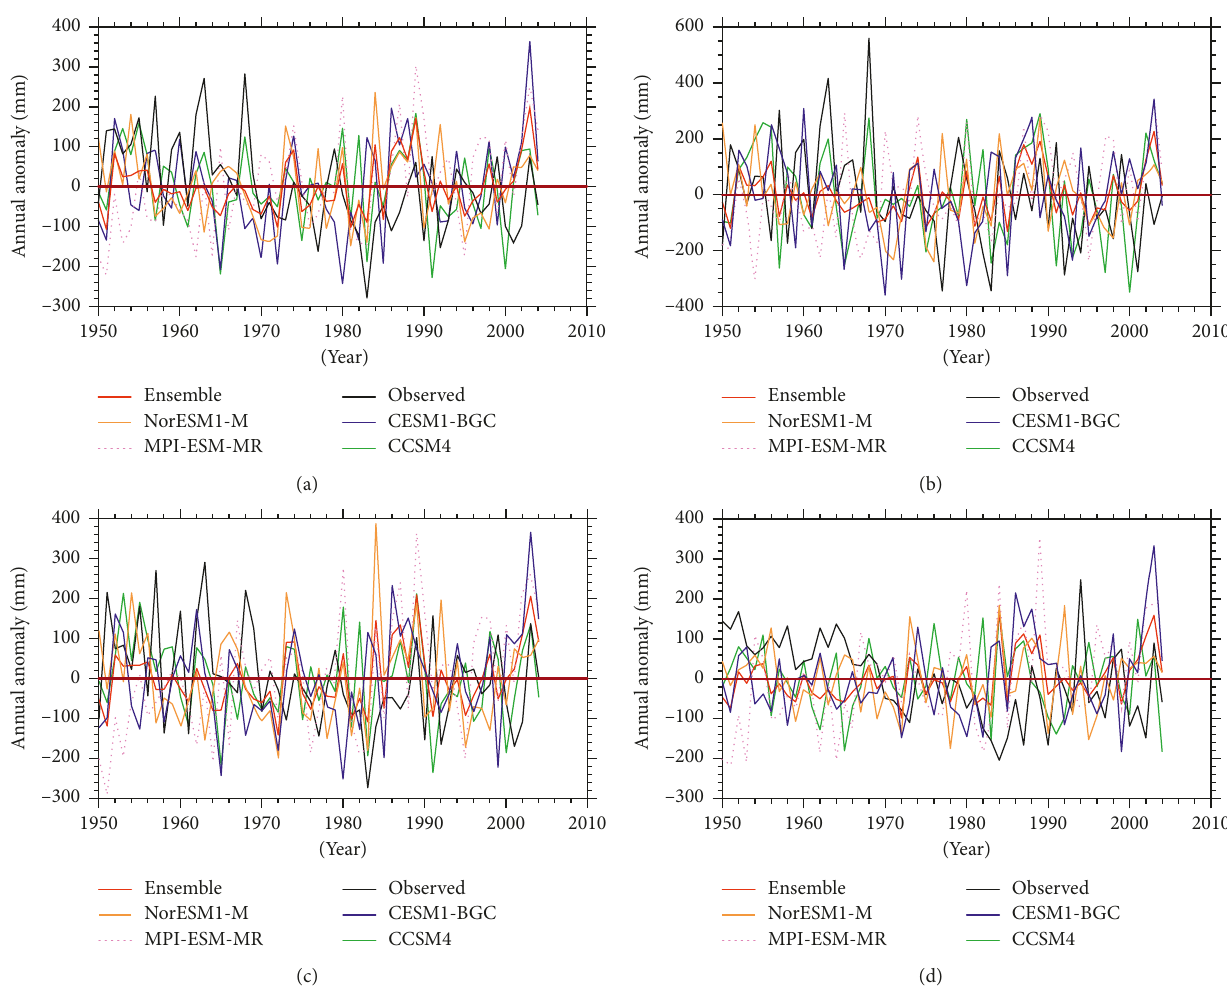
Figure 13: The series of interannual variability over the Volta Basin (a), the Guinea Coast (b), the Soudano-Sahel (c), and the Sahel (d). The anomaly is calculated using the 1950–2004 period